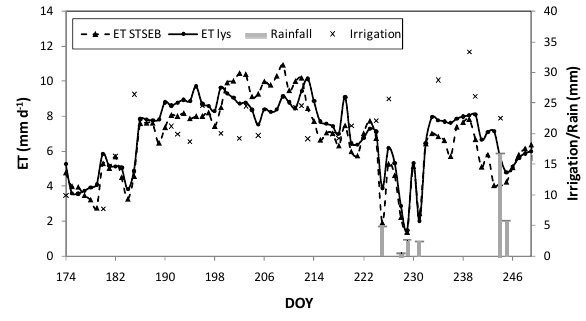
Figure 7. Evolution of the sorghum daily ET values modelled (STSEB) and measured 10 Fig. 7. Evolution of the sorghum daily ET values modelled (lys) for the experiment duration. Rainfall and irrigation water quantities are also 11 (STSEB) and measured (lys) for the experiment duration. Rainfall plotted. 12 and irrigation water quantities are also plotted.